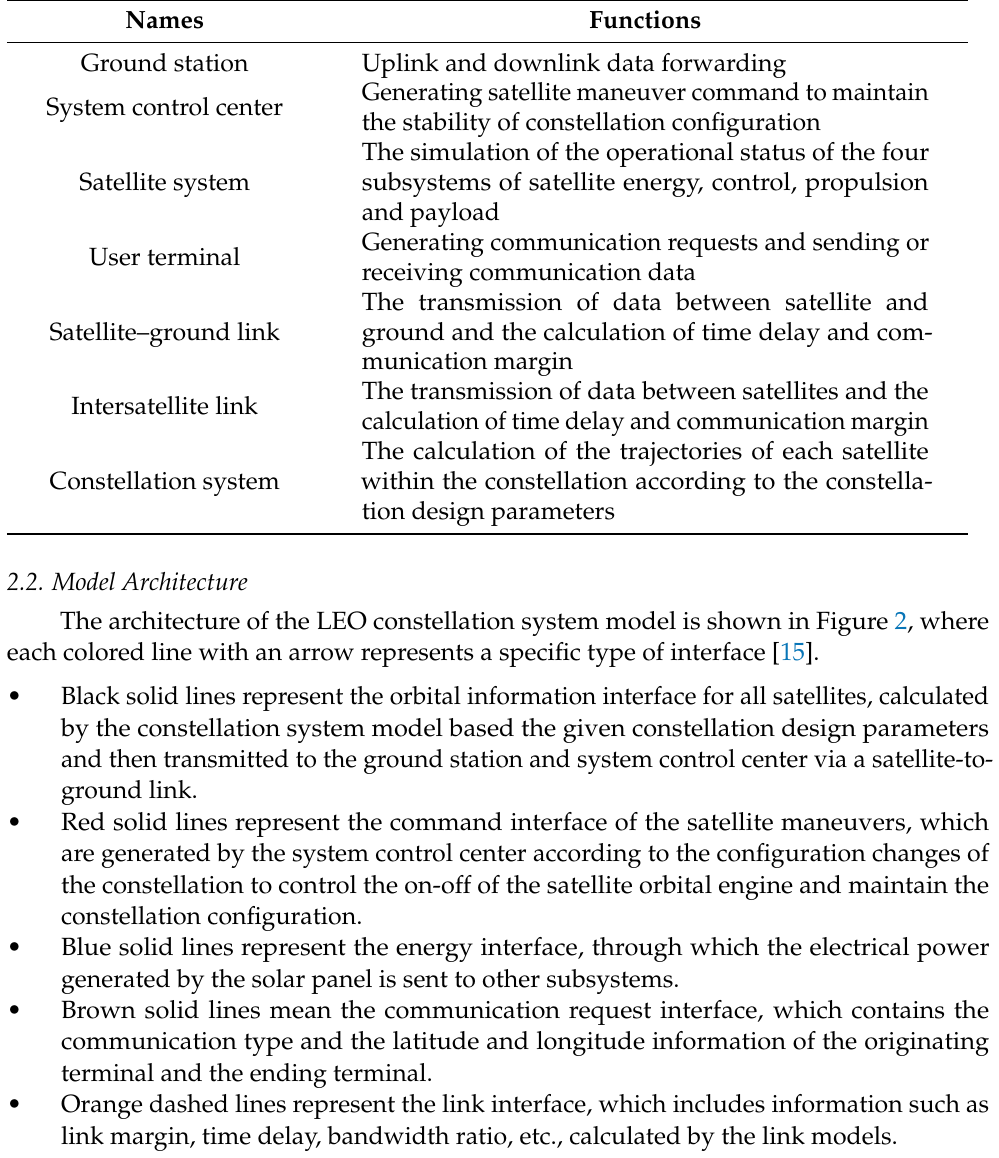
Table 1. Key components of satellite constellation system